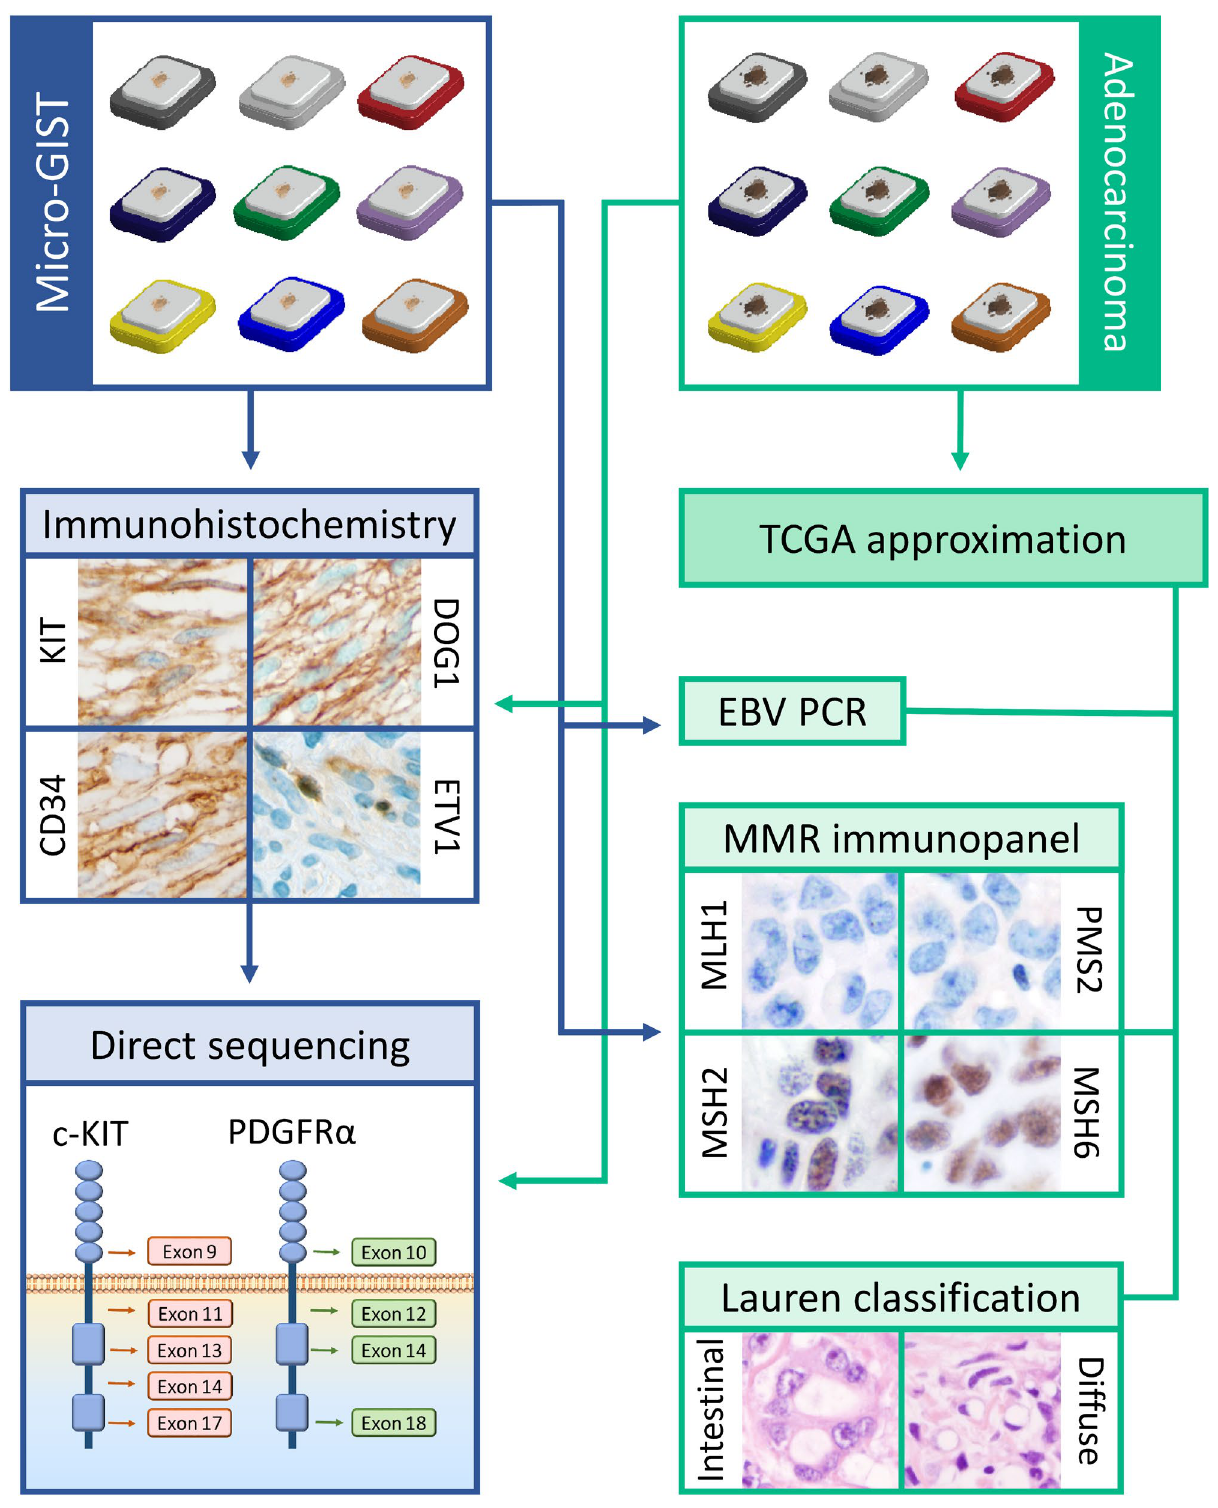
Figure 1. Workflow of the study. Cross-testing the markers of the major pathogenetic pathways of both micro- GISTs and gastric adenocarcinomas. micro-GIST microscopic gastrointestinal stromal tumor, MMR mismatch repair, EBV Epstein–Barr virus, PCR polymerase chain reaction, TCGA The Cancer Genome Atlas Project, PDGFRα platelet-derived growth factor-α, DOG1 discovered on GIST-1, ETV1 ETS translocation variant